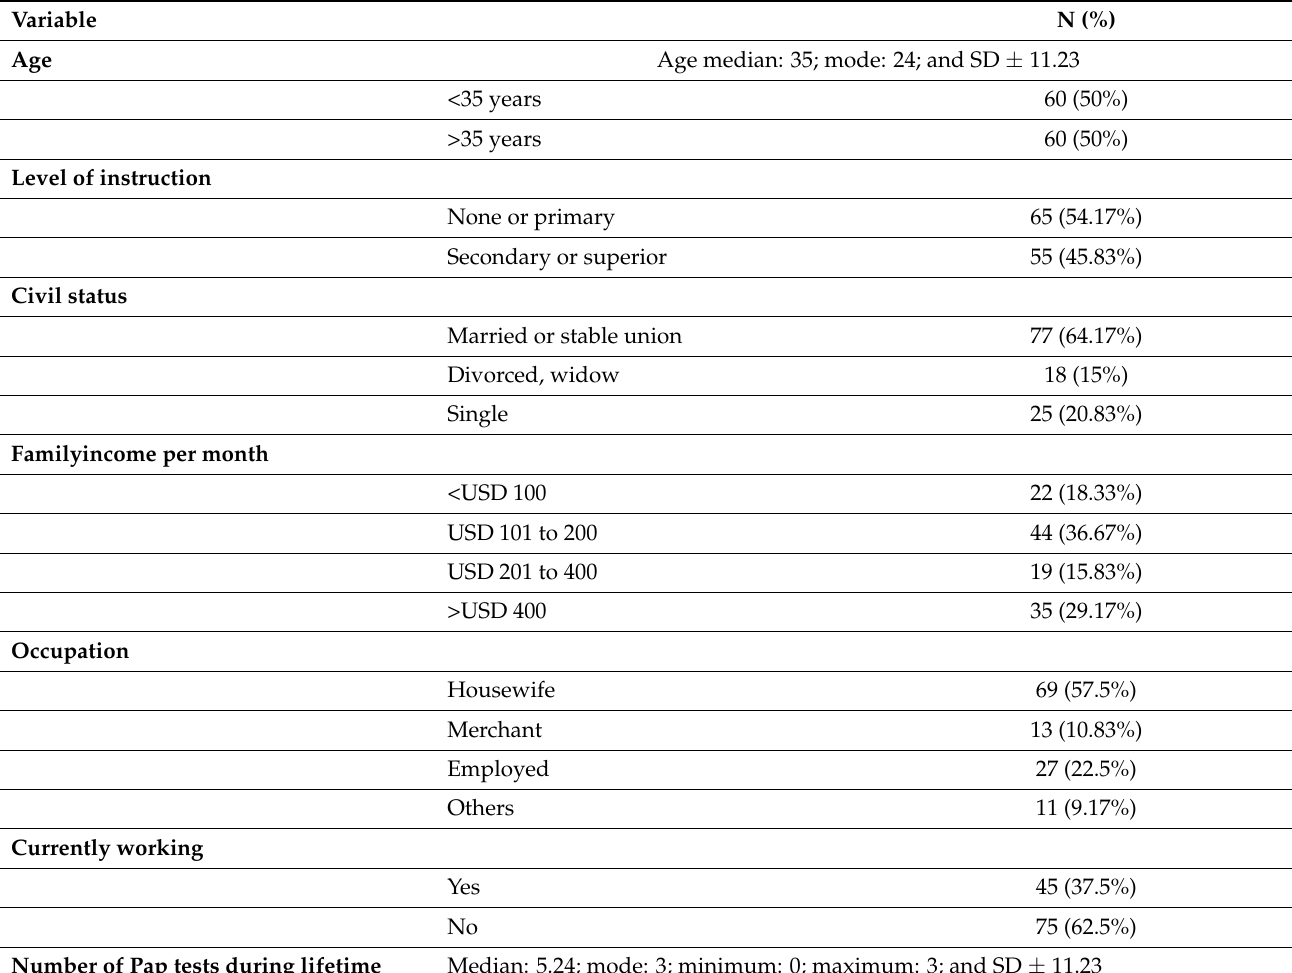
Table 1. Participants’ sociodemographic